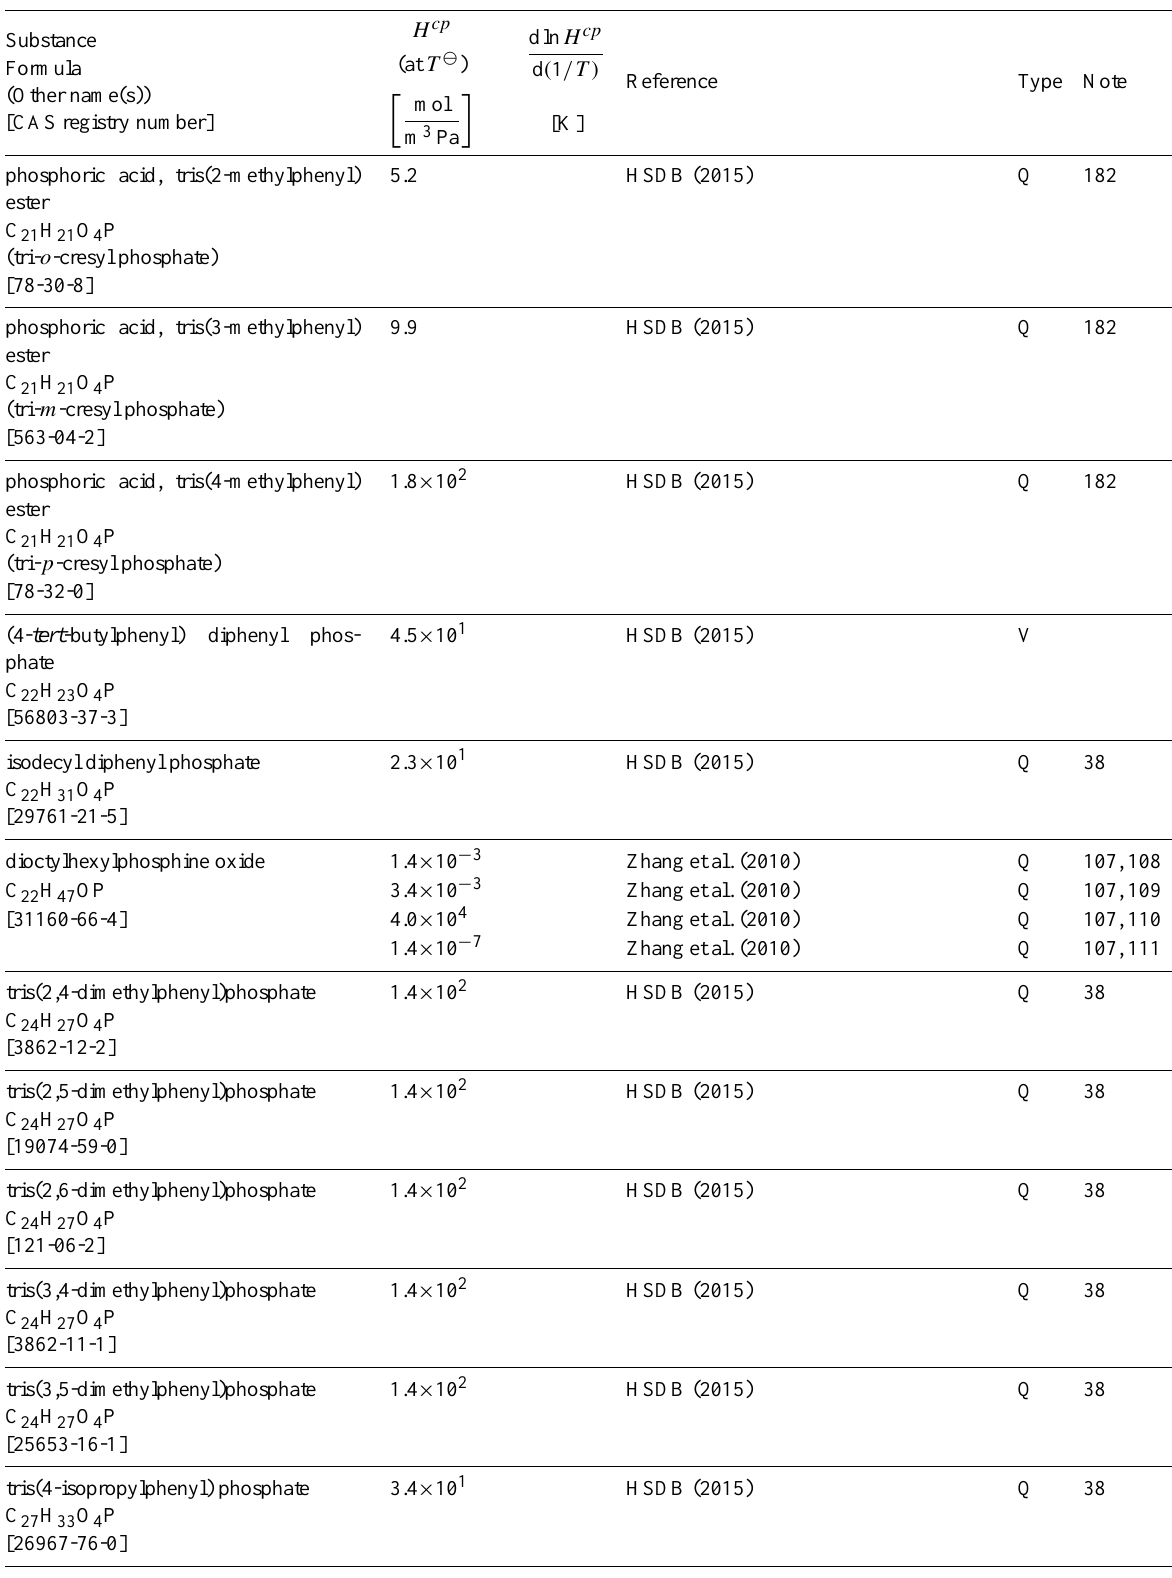
Table 6: Henry’s law constants for water as solvent